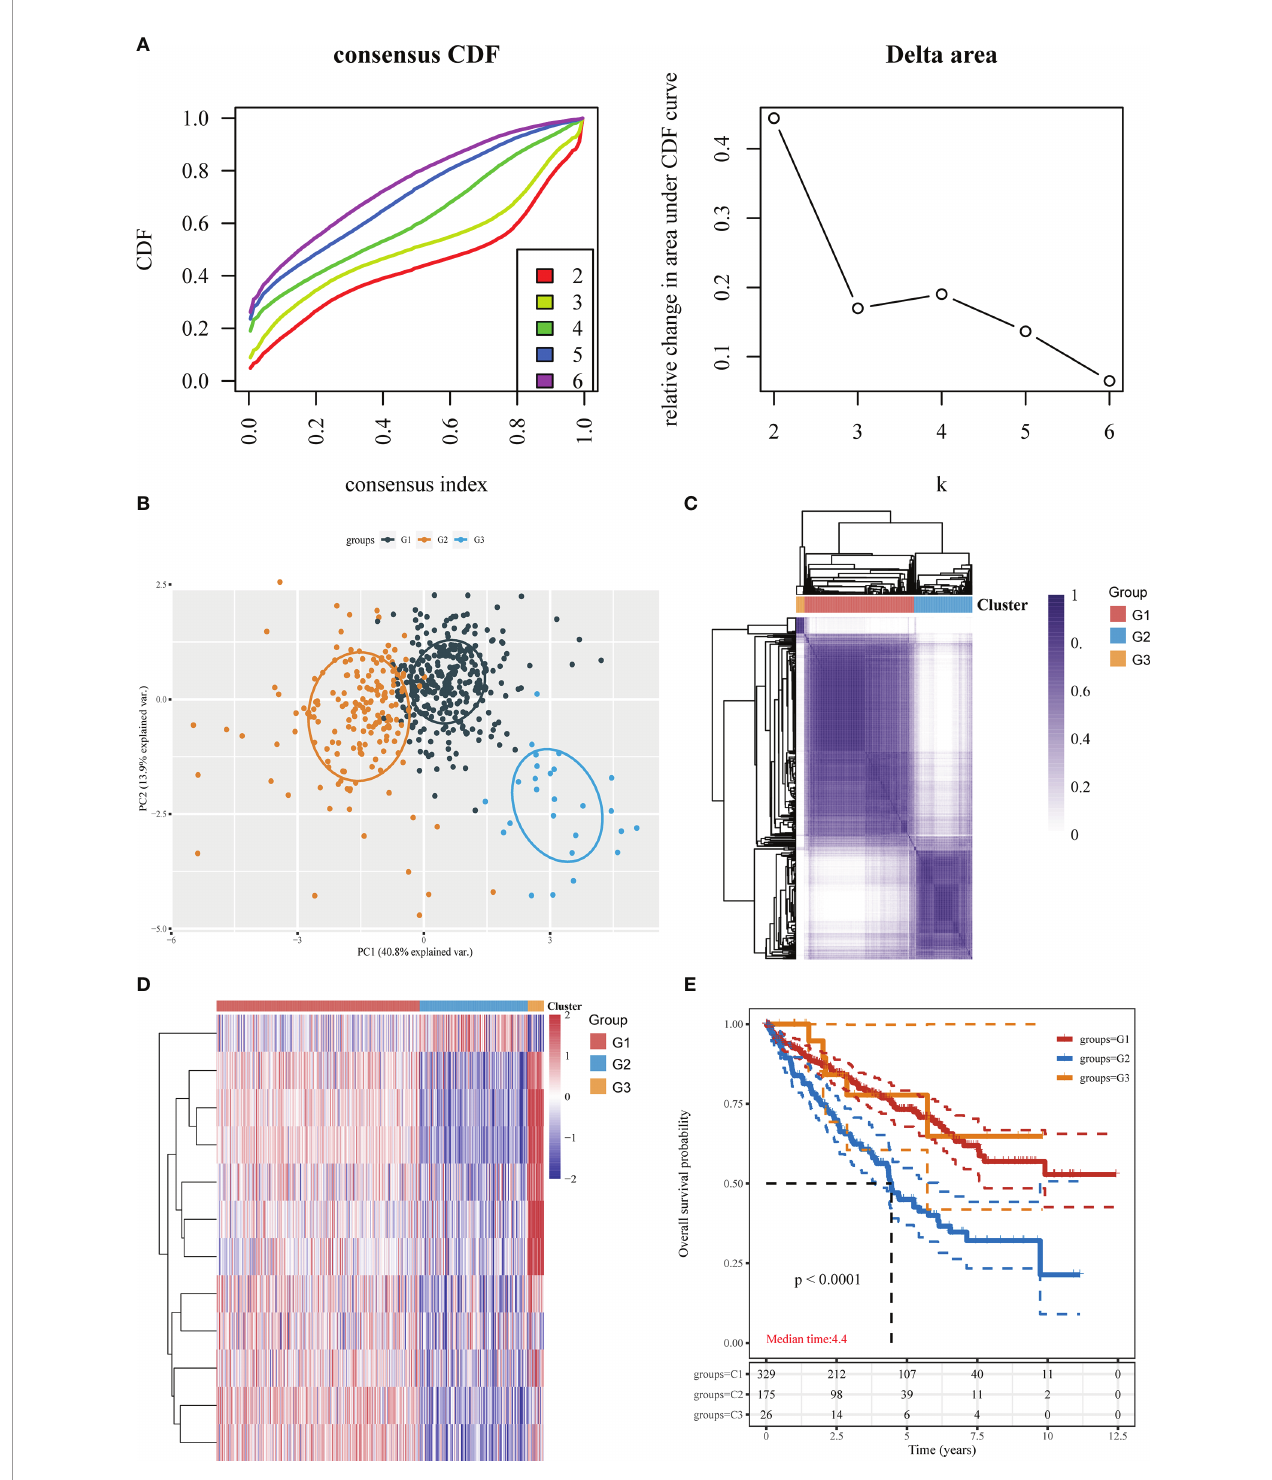
FIGURE 2 | Identi fi cation of cuproptosis subtypes in KIRC. (A) Consensus clustering cumulative distribution function (CDF) and relative change in the area under the CDF curve (CDF delta area). (B) The obtained subtypes were subjected to PCA. (C) Three cluster subgroups. (D) Heatmap showing the DEGs among the 3 subtypes. (E) KM survival analysis of the different groups of samples from the TCGA